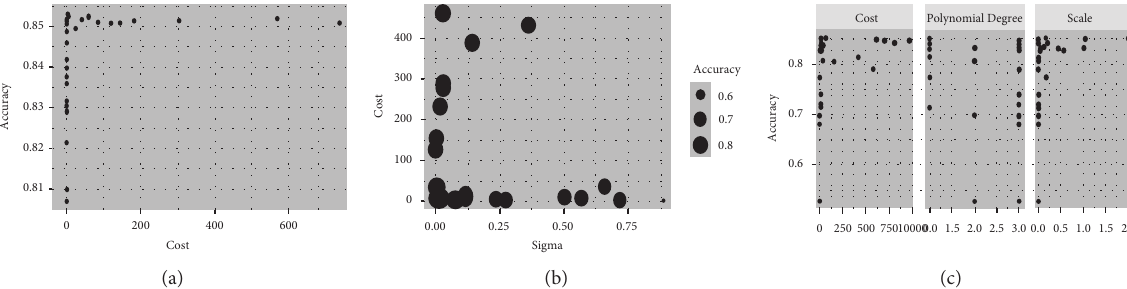
Figure 5: Optimized parameter selection using the grid search technique for KOSPI index with (a) linear kernel, (b) radial basis kernel, and (c) polynomial kernel of degree 2.